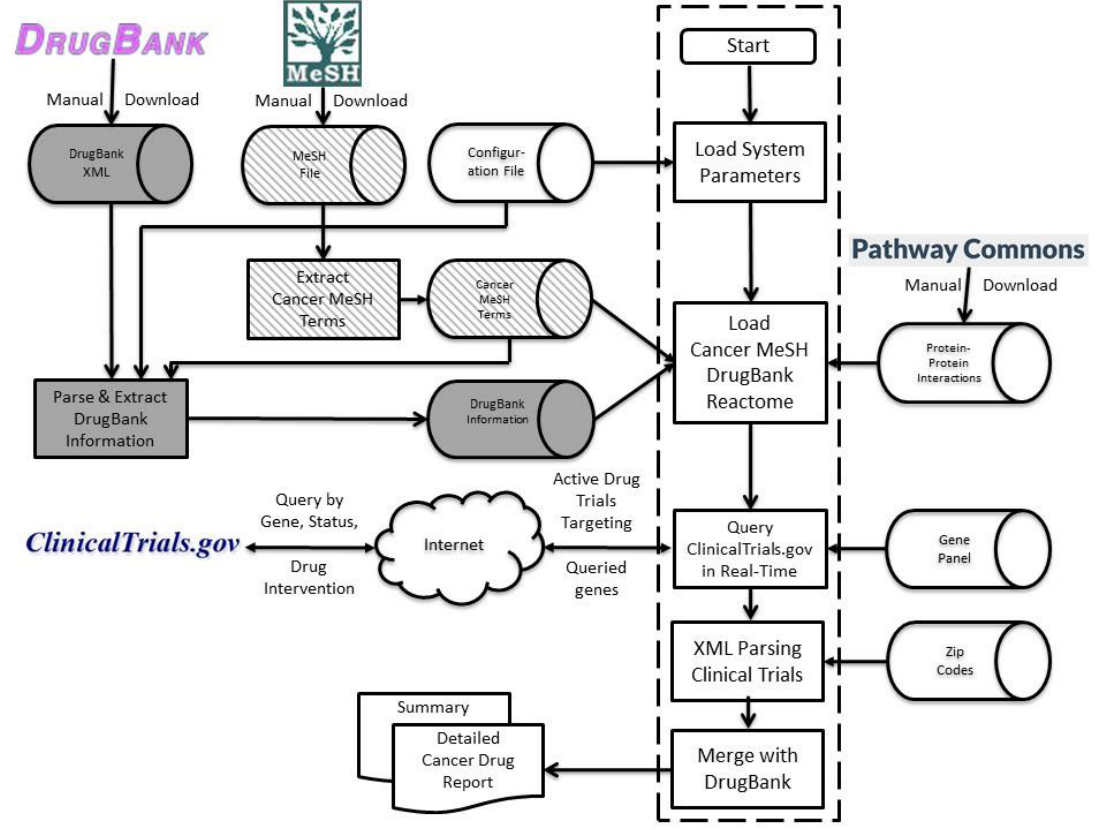
Figure 4. System architecture of IDICAP. The solid shaded components pertain to the process to parse and extract relevant drug information from DrugBank. The diagonally shaded components represent the process to select neoplasm Medical Subject Headings (MeSH) terms from the MeSH file downloaded from the National Library of Medicine. The components inside the dashed box form the IDICAP processing. IDICAP requires six files to run: the configuration file, gene panel file, gene-gene interaction (or reactome) data downloaded manually from Pathway Commons, cancer MeSH terms file, DrugBank information file, and the zip code file.